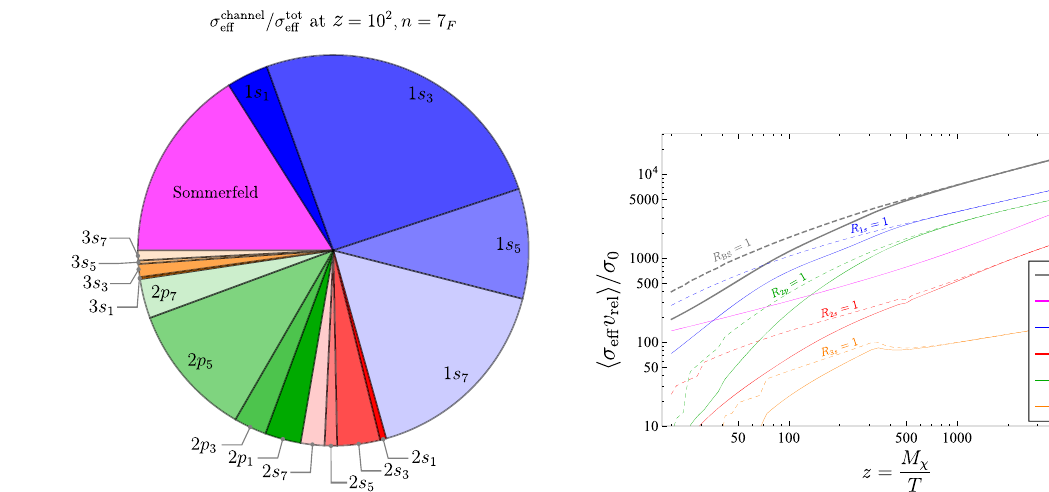
Fig. 10 Left: piechart showing the contributions to the 7-plet effective annihilation cross-section of each single BS channel, together with the SE, at fixed T = 10 − 2 M χ (i.e. z = 10 2 ). Right: temperature